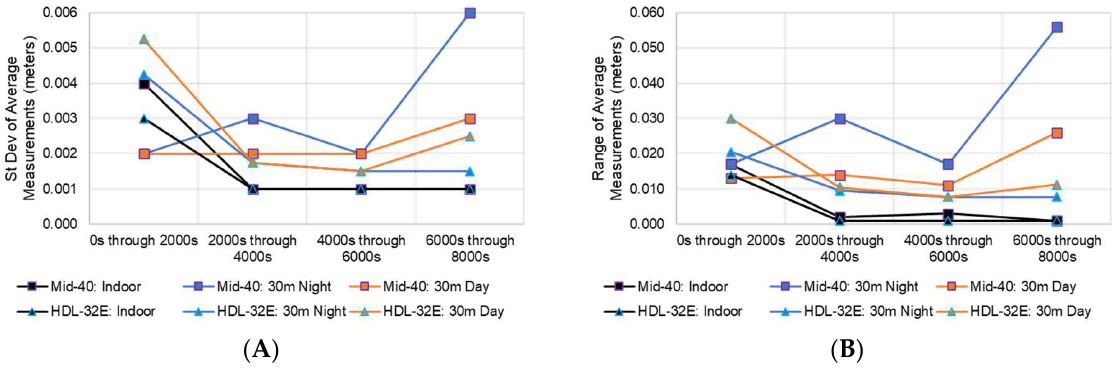
Figure 35. Calculated ( A ) standard deviation and ( B ) range of Velodyne ® HDL–32E and Livox ® Mid–40 over duration for all experiments.